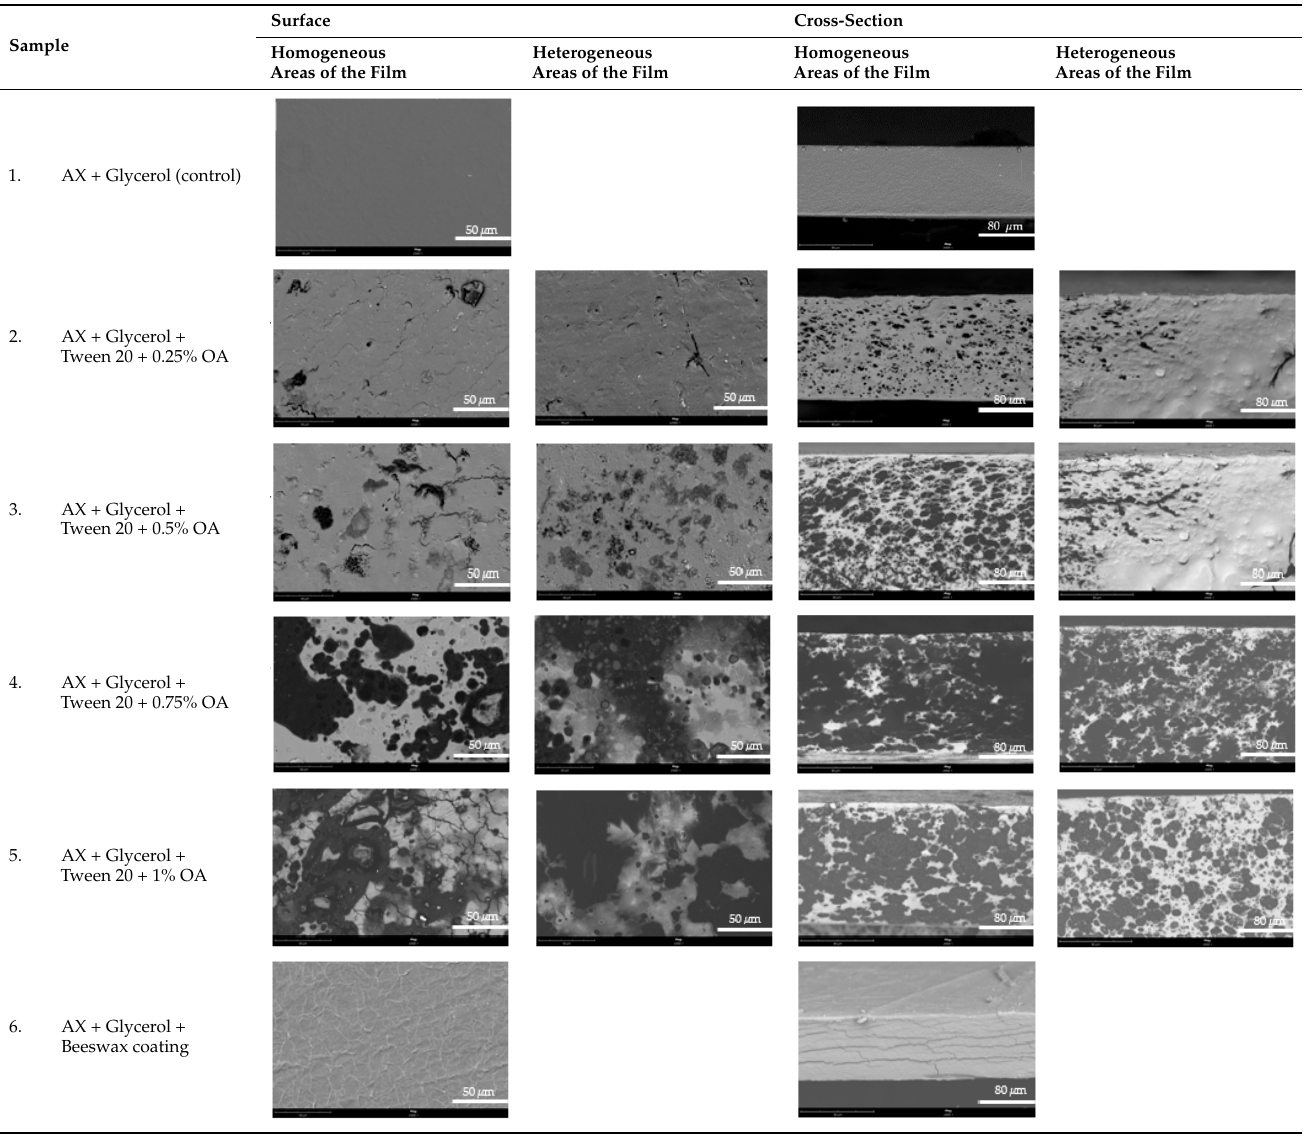
Table 5. SEM images of the surfaces and cross-sections of all the film samples.